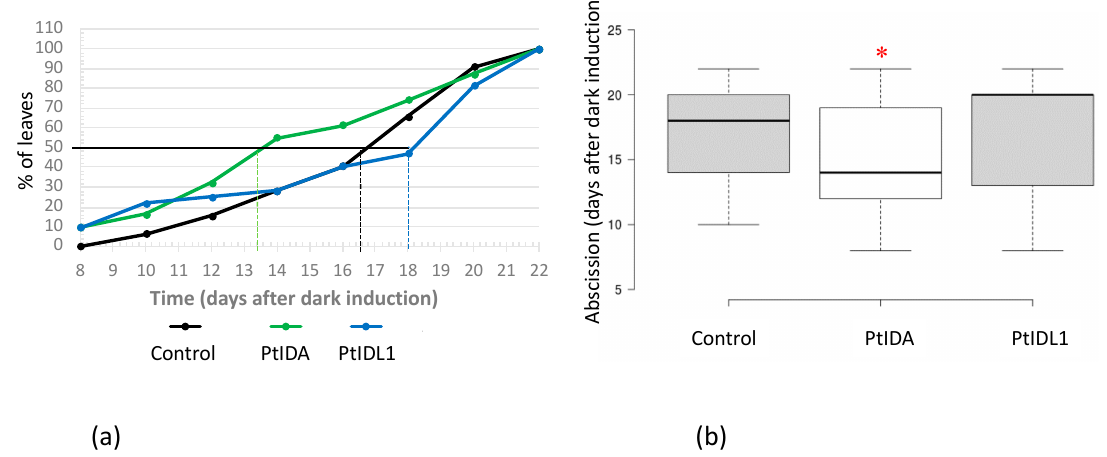
Figure 1. Poplar leaf abscission induced by dark treatment is enhanced in response to PtIDA or PtIDL1 peptide treatments of leaf axils. ( a ) Time course of treatment with 0.1 µ M PtIDA, PtIDL1, or water (control) 7 days after dark induced abscission. The percentage of dark-induced leaves dropped. n = 31 leaves for PtIDA and n = 32 for control treatment (water) and PtIDL1; dotted lines represent timepoints when 50% of the leaves were dropped. ( b ) PtIDA-treated leaves separated significantly earlier (*, t-test; n = 31 or 32 leaves; p < 0.05) than mock-treated leaves. Boxplot: central lines represent the median, limits of boxes are the 25th and 75th percentiles, and whiskers are the 1.5 × interquartiles.